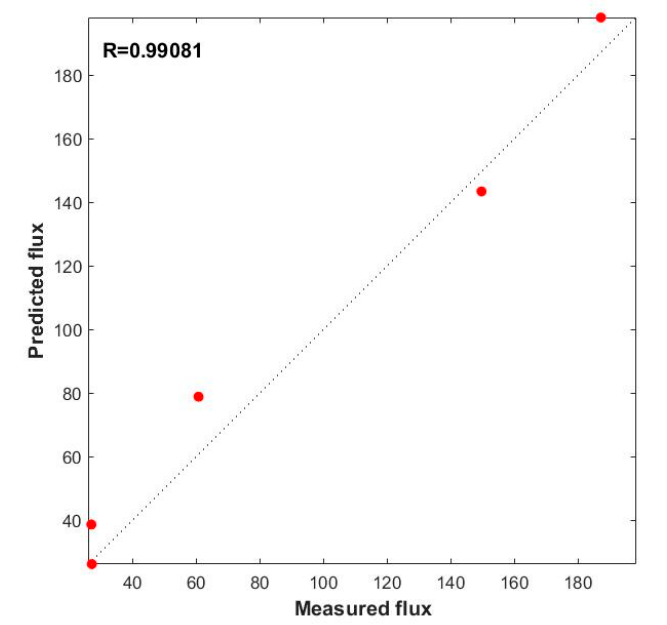
Table 6. Performance of the ANN model in predicting fluxes for the datasets given in Table 5.